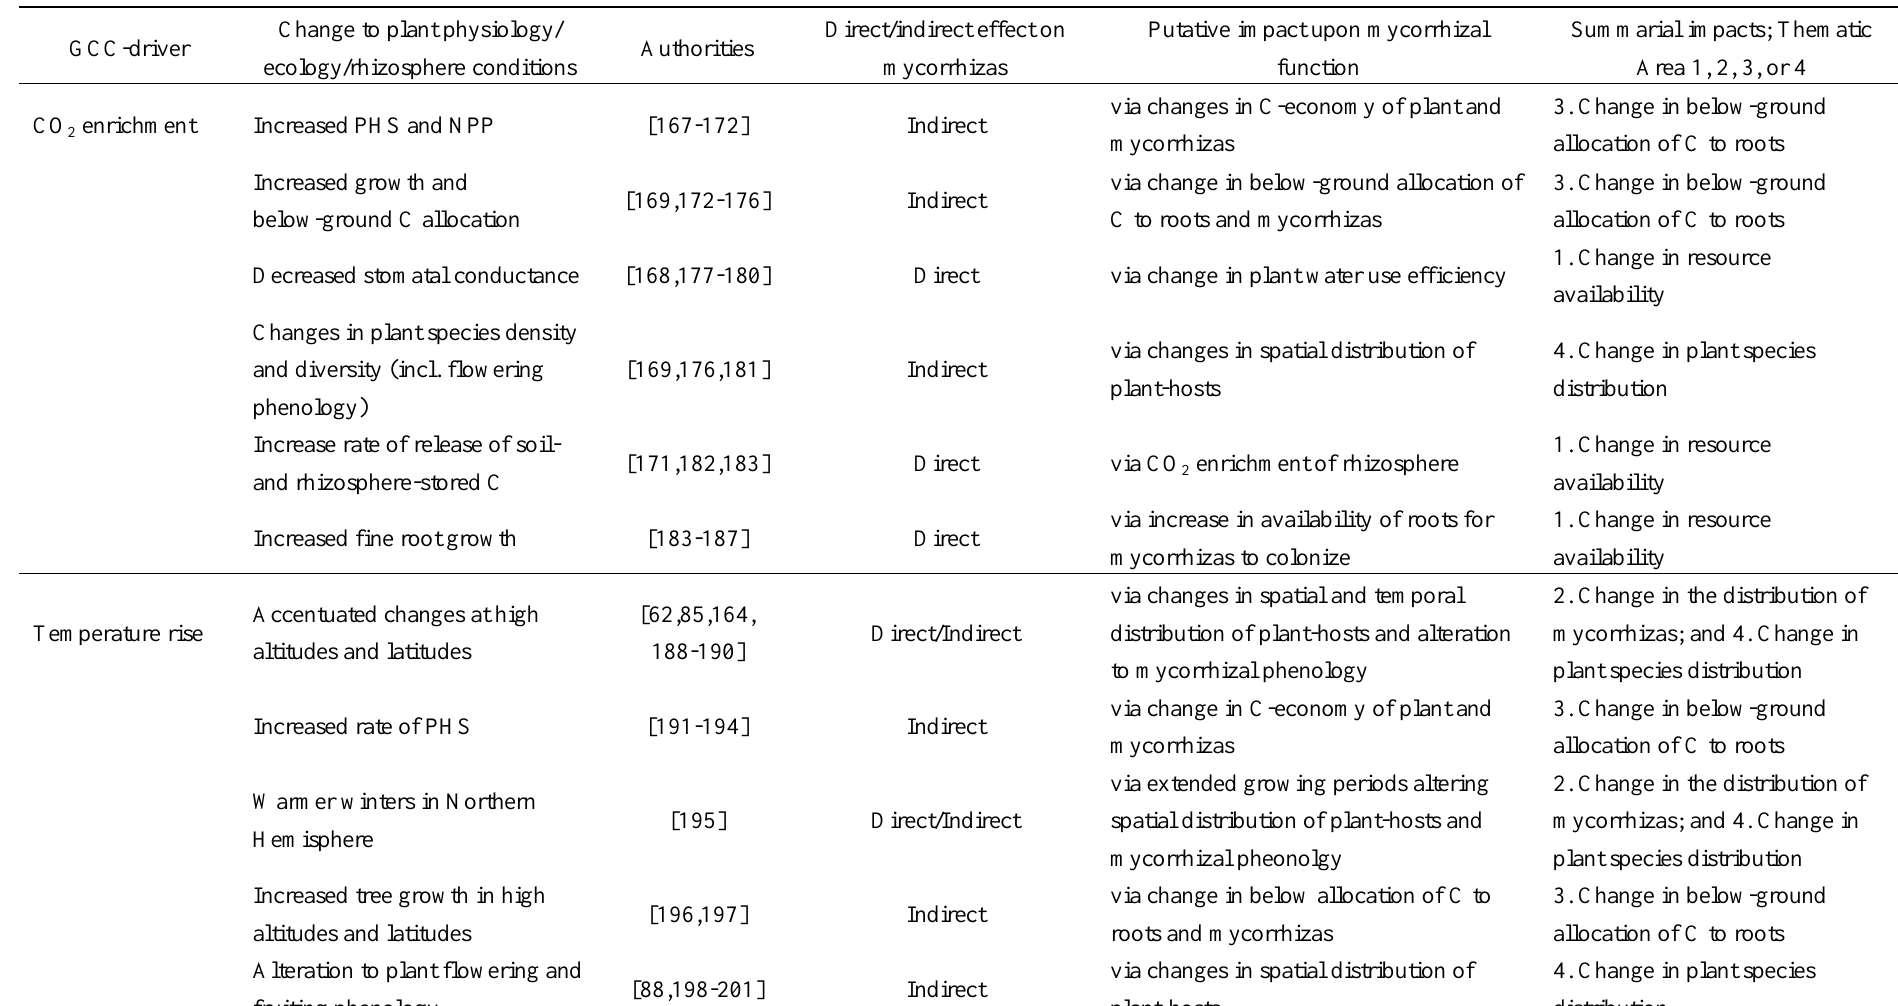
Table 5. GCC-drivers mediating changes to plants and ecosystems relevant to mycorrhizal function. See Figure 3 for conceptual relationships intrinsic to this table. PHS = Photosynthesis; NPP = Net Primary